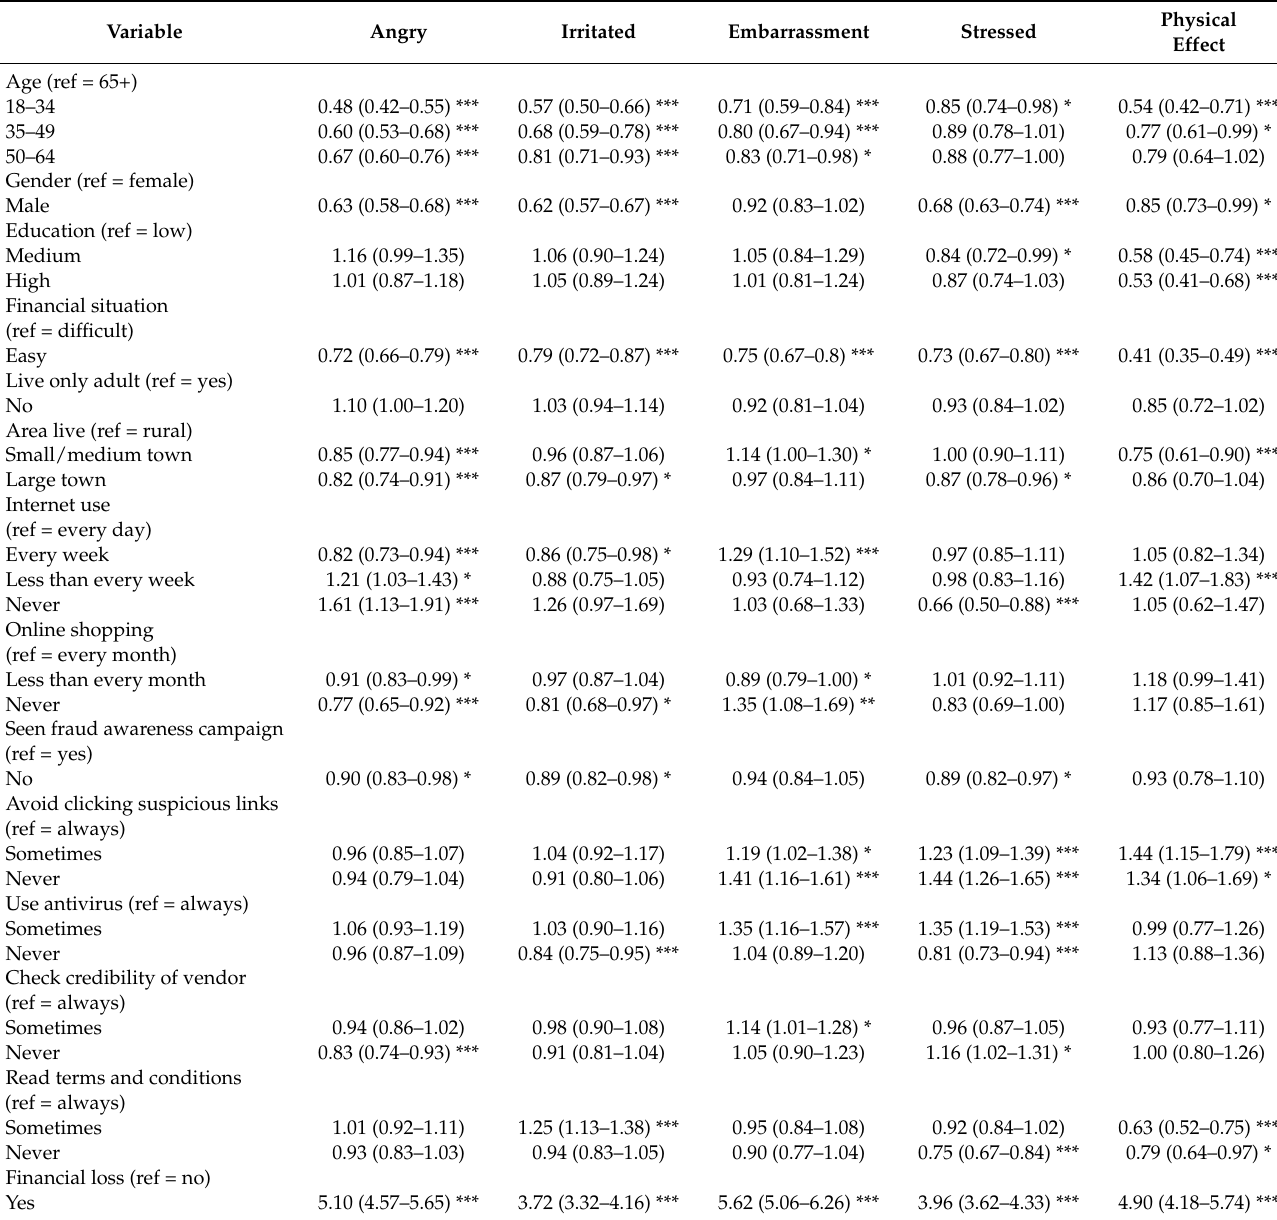
Table 11. Odds ratios and 95% CI for non-financial effects of fraud ( n =